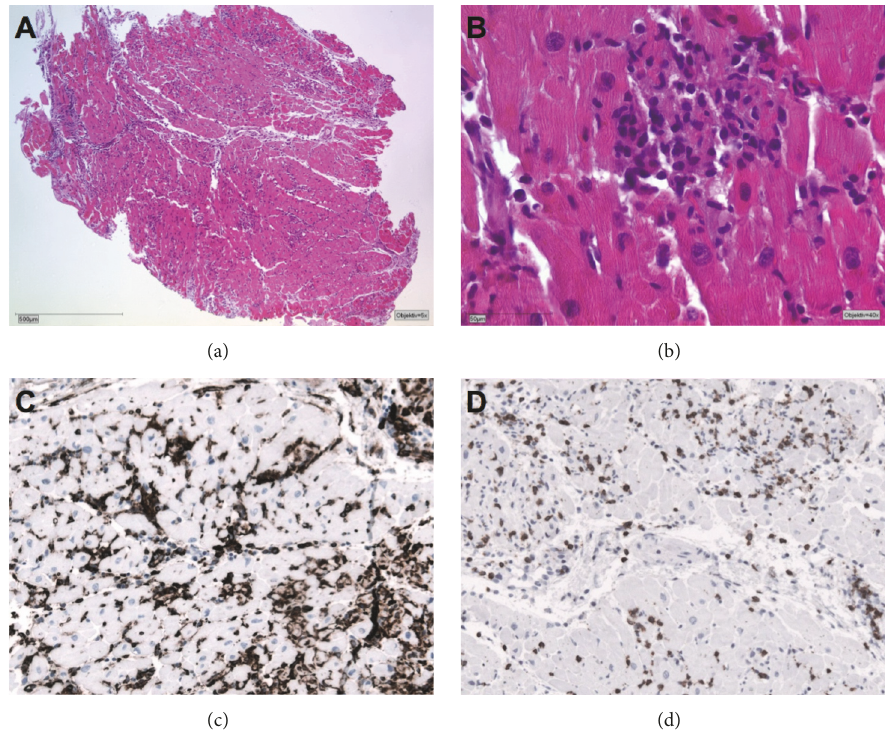
Figure 4: Endomyocardial biopsy. Histological detection of massive infiltration by mononuclear inflammatory cells: (a) overview section (50x); (b) cluster infiltrated immunocompetent cells (purple, 400x), myocardial damage; (c) MHCII-overexpressing immunocompetent cells (esp. macrophages, 200x); and (d) CD3-T-lymphocytes (brown